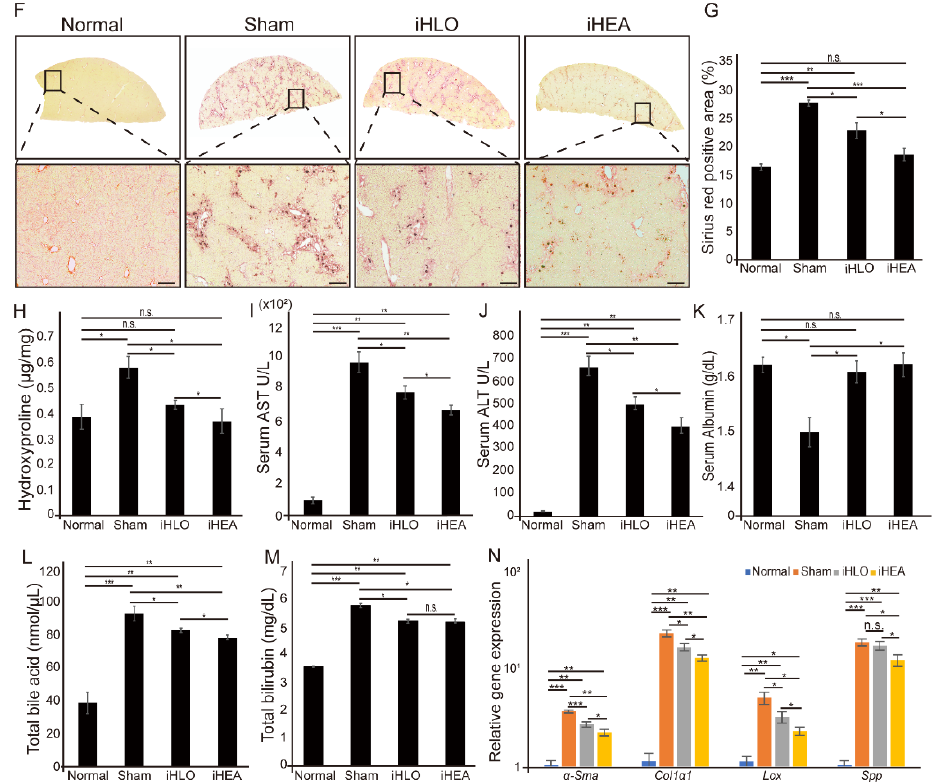
Figure 5. Transplantation of iHLOs and iHEAs in DDC-induced cholestatic liver fibrosis model. ( A ) Schematic overview of experiments analysis of the effect of iHLOs and iHEAs in DDC4-induced cholestatic liver fibrosis model. ( B ) iHLOs and iHEAs in kidney subcapsular region 2 weeks after transplantation. ( C ) Immunofluorescence images of iHLOs and iHEAs engrafted in the kidney subcapsular region (K = kidney) stained with Alb, mouse CD31, and human CD31. The cells were counterstained with DAPI. Scale bar: 50 µ m. ( D ) H&E staining images of DDC-induced cholestatic liver fibrosis mice model. Scale bar: 150 µ m. ( E ) Measurement of the total porphyrin content in the liver lysate conducted by utilizing the total intrinsic fluorescence of the demetallated porphyrin contents including Uro, Copro, PP-IX, and NMP ( n = 8). ( F ) Sirius Red staining images of whole liver section of DDC-induced cholestatic liver fibrosis mice model. The black box is enlarged below. Scale bar: 150 µ m. ( G ) Quantification of the collagen deposition (%) of liver isolated from normal, sham iHLO- and iHEA-transplanted mice stained by Sirius Red ( n = 10). Collagen deposition area (%) was analyzed with Image J 1.51J software. ( H ) Measurement of the total collagen content in the liver of normal, sham treated, and iHLO- and iHEA-transplanted mice by hydroxyproline assay ( n = 8). ( I ) Serum levels of aspartate aminotransferase (AST). (J ) Serum levels of alanine aminotransferase (ALT). ( K ) Serum levels of albumin ( n = 8 mice per group). ( L ) Serum levels of total bile acid. ( M ) Serum levels of total bilirubin ( n = 5 mice per group). ( N ) qPCR analysis of fibrosis and hepatic stellate cell activation including alpha-smooth muscle actin: α Sma ; alpha-1 type 1 collagen: Col1a1 , lysyl oxidase: Lox ; and secreted phosphoprotein 1: Spp1 in sham, iHLO- and iHEA-transplanted liver tissues relative to normal liver tissues. The transcriptional levels were normalized to the housekeeping gene ( Gapdh ). Error bars indicate standard errors from samples ( n = 5 mice per group). * p < 0.05, ** p < 0.005, *** p < 0.0005, n.s. = not